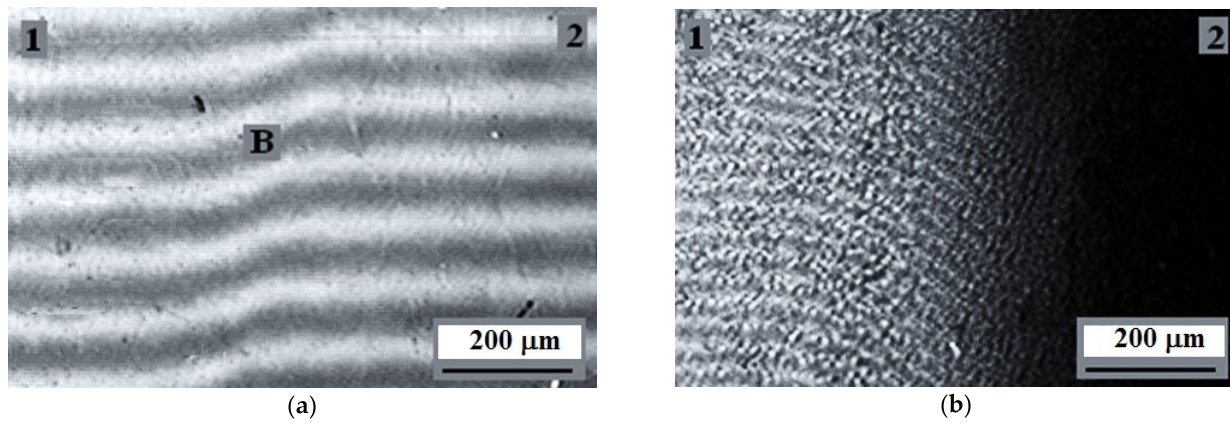
Figure 7. Interferogram of the interdiffusion zone ( B ) of LLDPE ( 1 ) and low molecular weight HDPE-1 ( 2 ) at temperatures of 160 °C ( a ) and 22 °C after crystallization of the components ( b ).